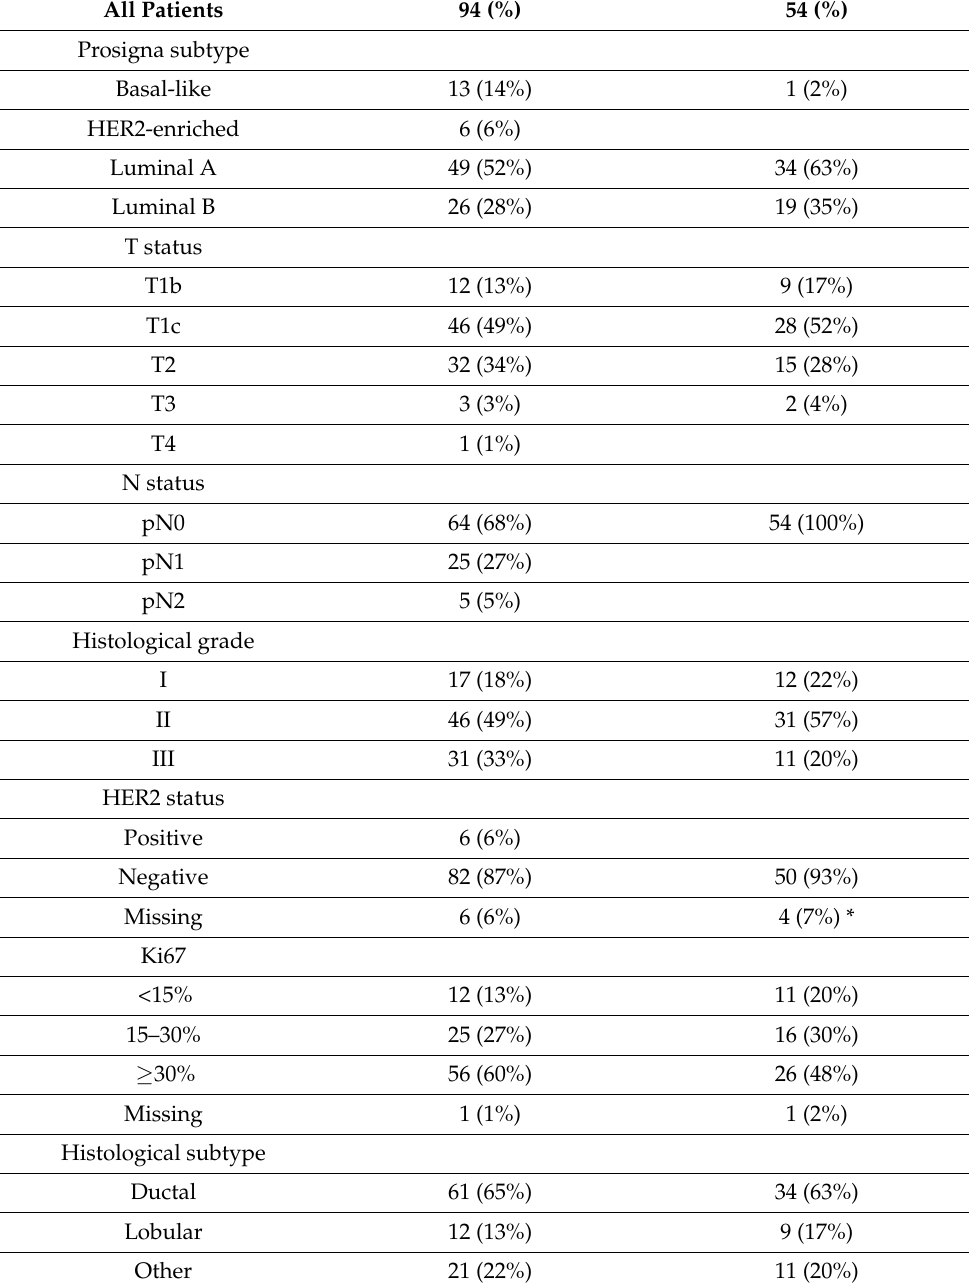
Table 1. Clinical overview of all 94 samples, and the subset of 54 that were